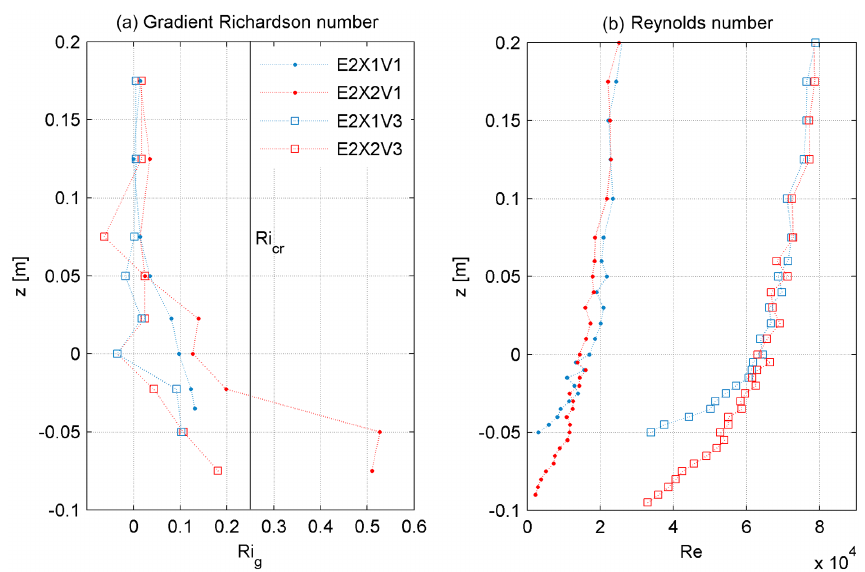
Figure 8. Vertical profiles of the (a) gradient Richardson number Ri g calculated from temperature and wind velocity gradients over a layer of d z = 0 . 025m and (b) Reynolds number Re calculated from the local wind velocity at each measurement point.